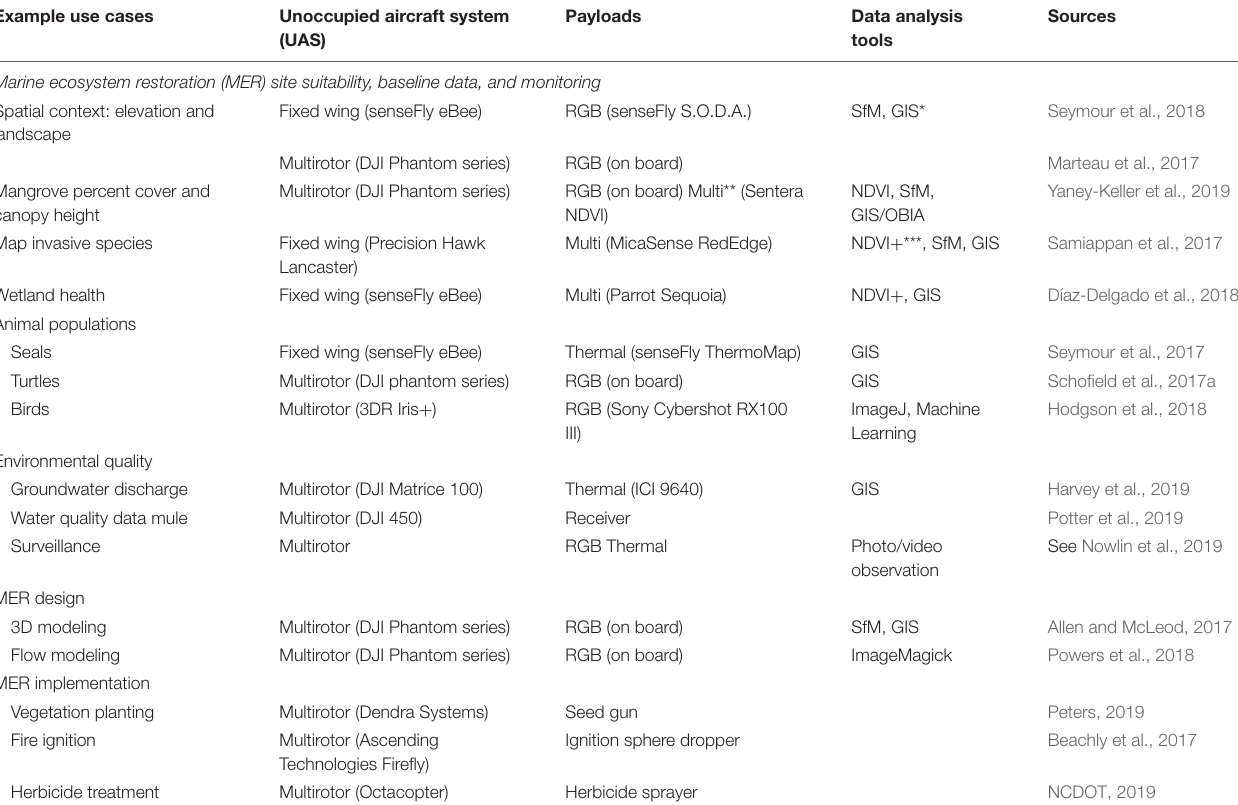
TABLE 1 | Representative use cases with associated aircraft, payloads, and primary data analysis tools. Example use